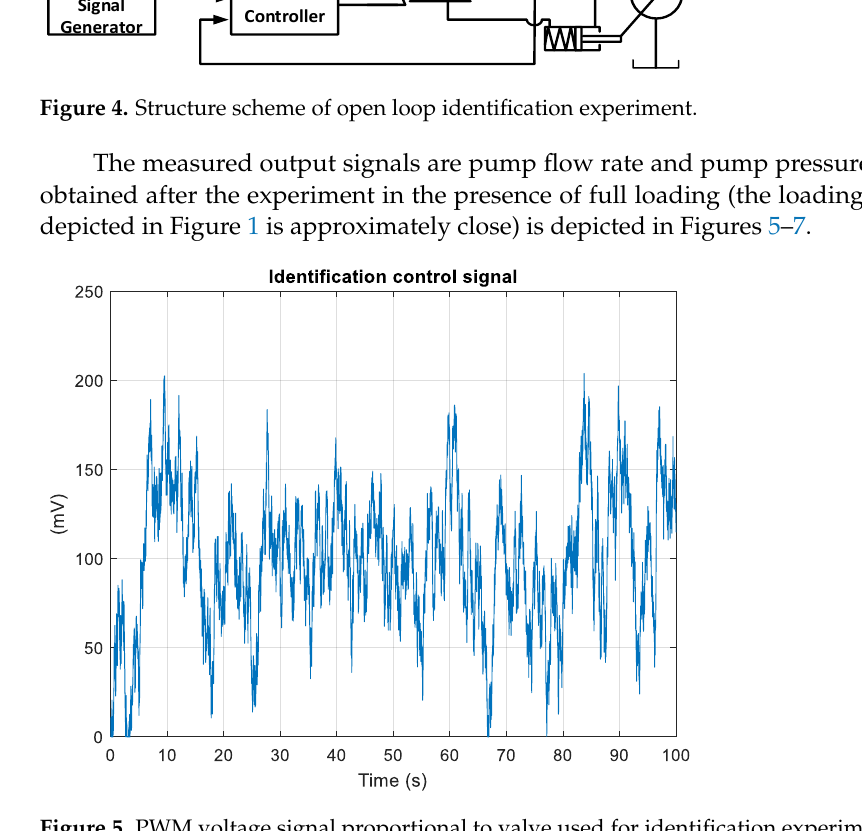
Figure 5. PWM voltage signal proportional to valve used for identification experiment.